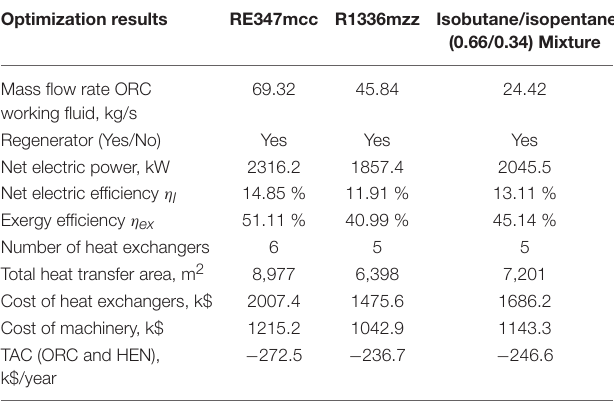
TABLE 4 | Data for the techno-economic optimization. Parameter